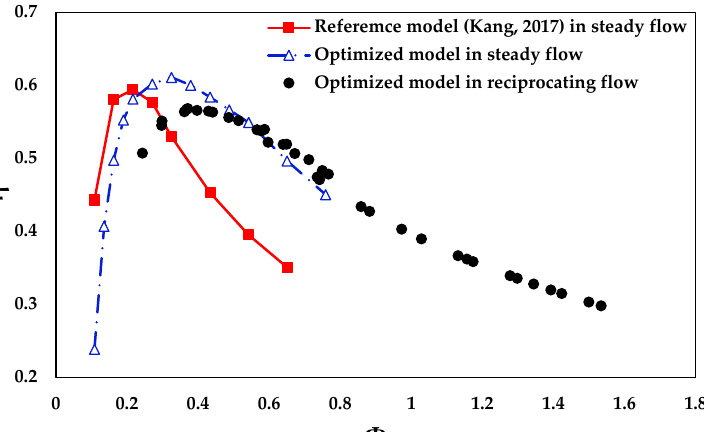
Figure 12. Comparison of the reference and optimized model performance in steady and reciprocating air flows by CFD.